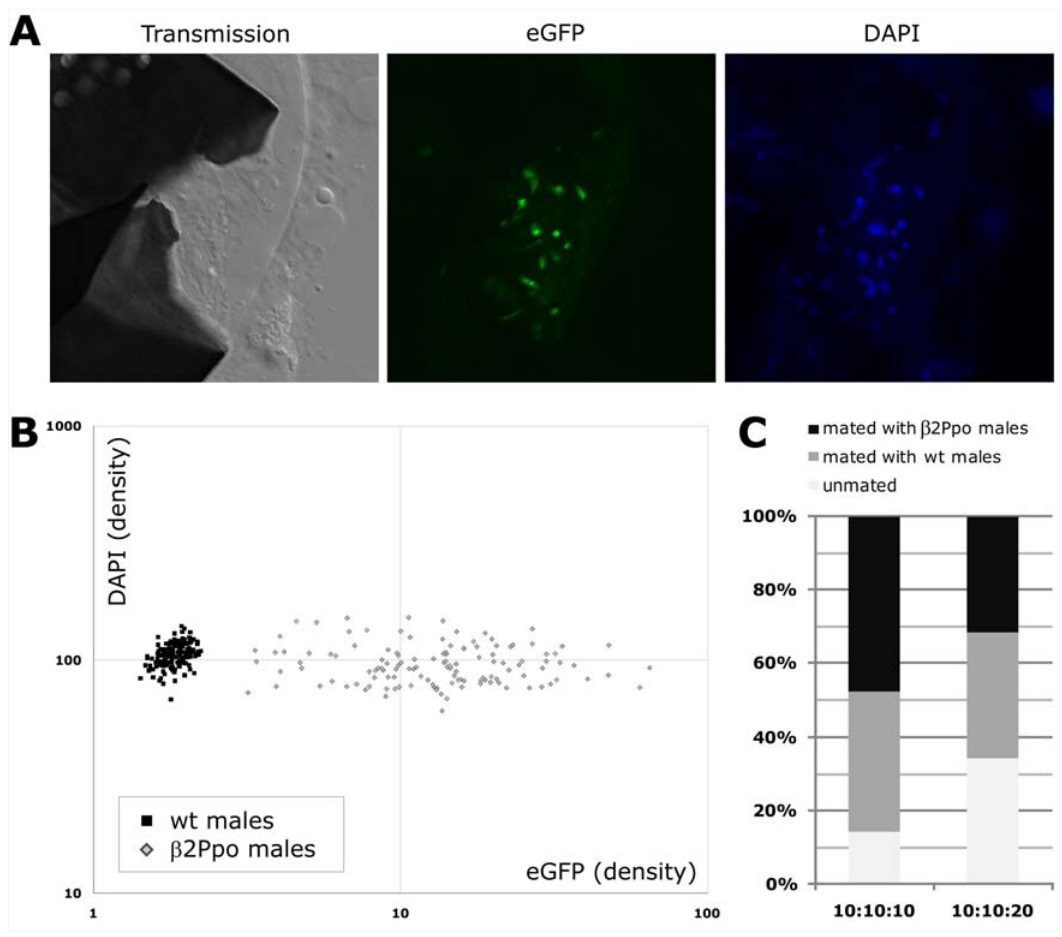
Figure 2. Confocal analysis of spermatozoa from b 2Ppo and WT males recovered from spermathecae of WT females. (A) Spermatheca of a female mated with b 2Ppo1 males analysed by transmission microscopy (left), analyzed for eGFP fluorescence (middle) and DNA stained with DAPI (right). (B) Analysis of confocal 3D data stacks of sperm extracted from spermathecae of females mated to WT or b 2Ppo males. Objects defined as sperm, on the basis of DAPI fluorescence and size, were analyzed in a way that GFP density (nuclear volume/fluorescence intensity) was plotted against DAPI density. Density values were plotted for each individual spermatozoa examined from wt (black rectangles) and transgenic (grey diamonds) males. (C) Assessment of mating capability of b 2Ppo2 against WT males. Equal numbers (10) of b 2Ppo and WT males were allowed to mate in the presence of 10 or 20 WT females for 6 days. The mating with WT and transgenic males was assessed by analyzing in PCR experiments the DNA extracted from the spermathecae using a first a marker revealing chromosome Y specific sequence, to provide an overall estimate of mating rate and a second marker for the I-PpoI coding sequence. PCRs experiments that failed to amplify any product were scored as non-mated. The figure shows the percentage of mated mosquitoes and the relative contribution of WT (grey) and transgenic males (black) in the mating. Shown is the combined average of 3 independent sets of experiments.